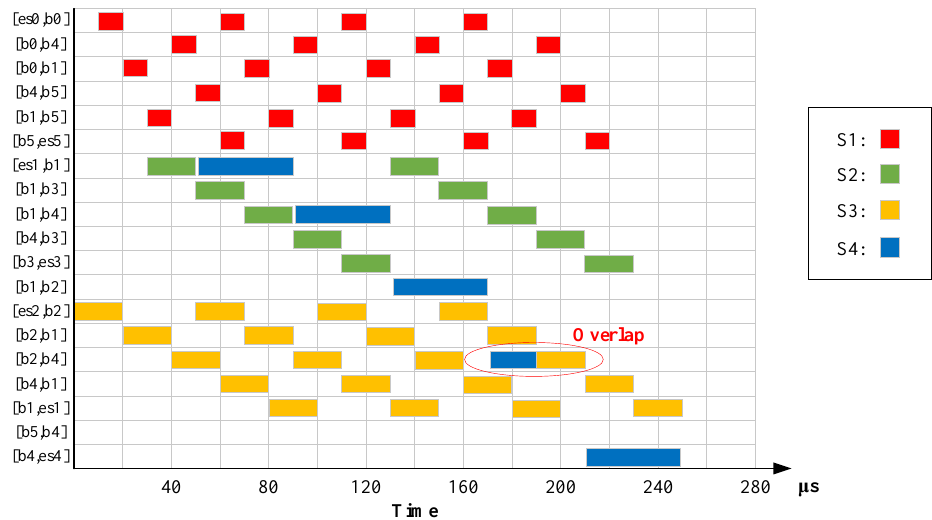
Figure 6. The no-wait schedule result of the illustrative SMR scheme in Figure 3.